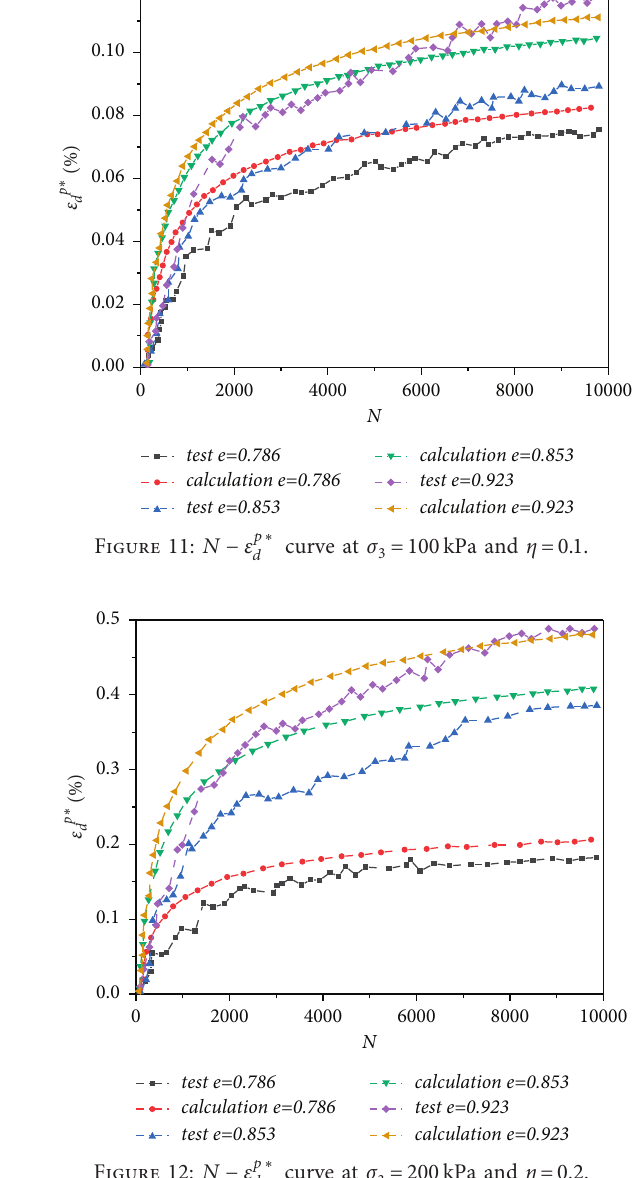
� 200kPa and η � 0.2. curve at σ 3 d